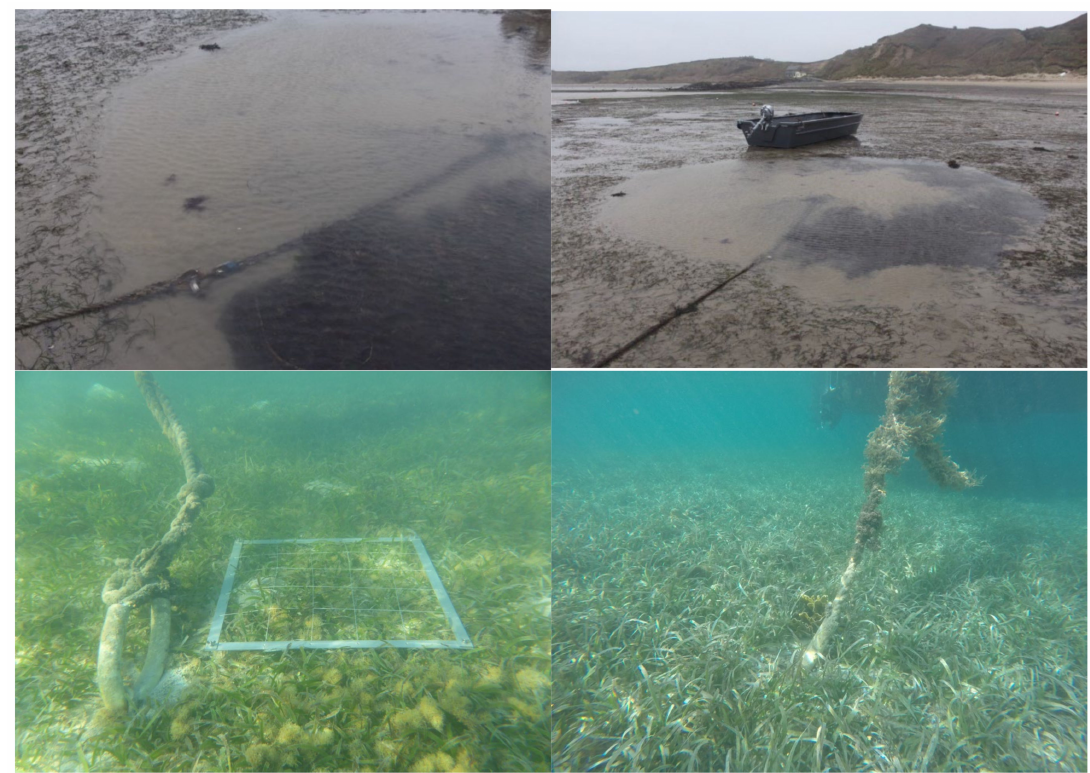
Scheme 2. Rope moorings in seagrass meadows in Porthdinllaen ( top left and right ) and Puerto Rico ( bottom left and right ). The moorings in Porthdinllaen show a marked low density halo up to the point at which the mooring changes from chain to rope. The moorings in Puerto Rico that are 100% rope show no such